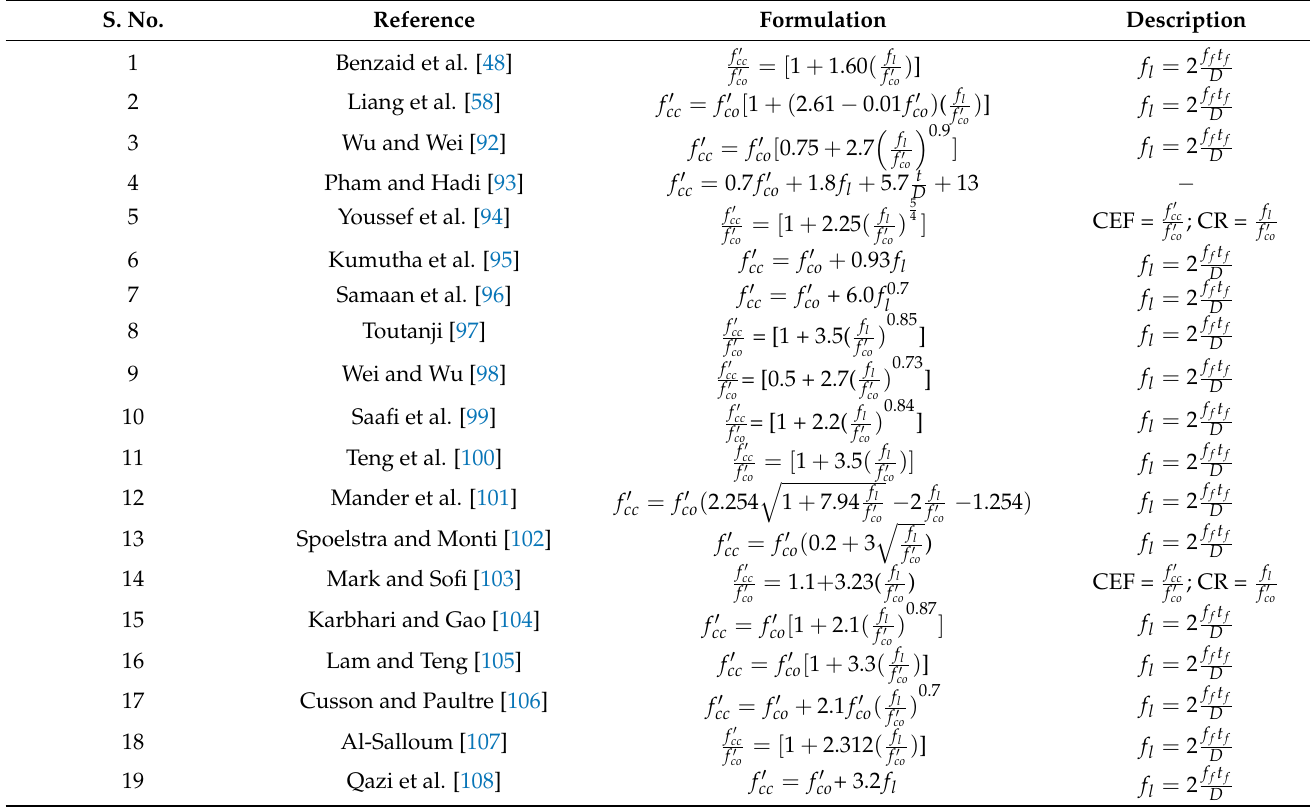
Table 3. Analytical models with description.